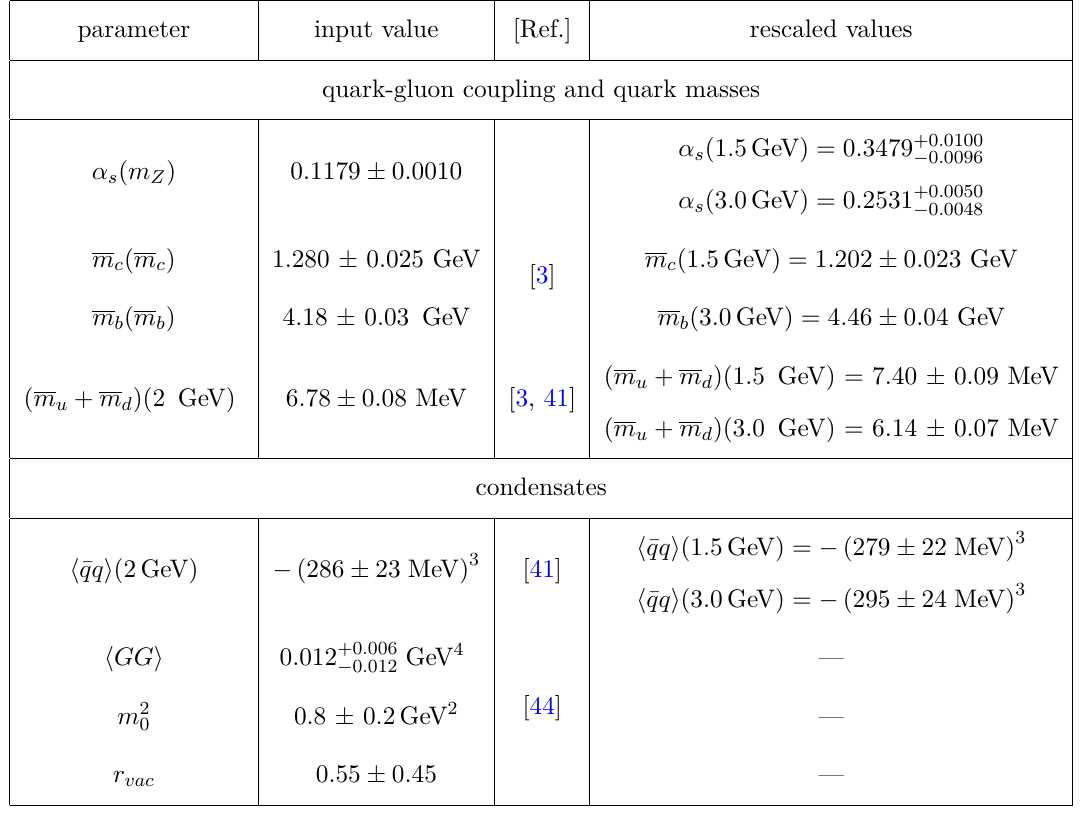
Table 1 . QCD parameters used in the LCSRs and two-point sum